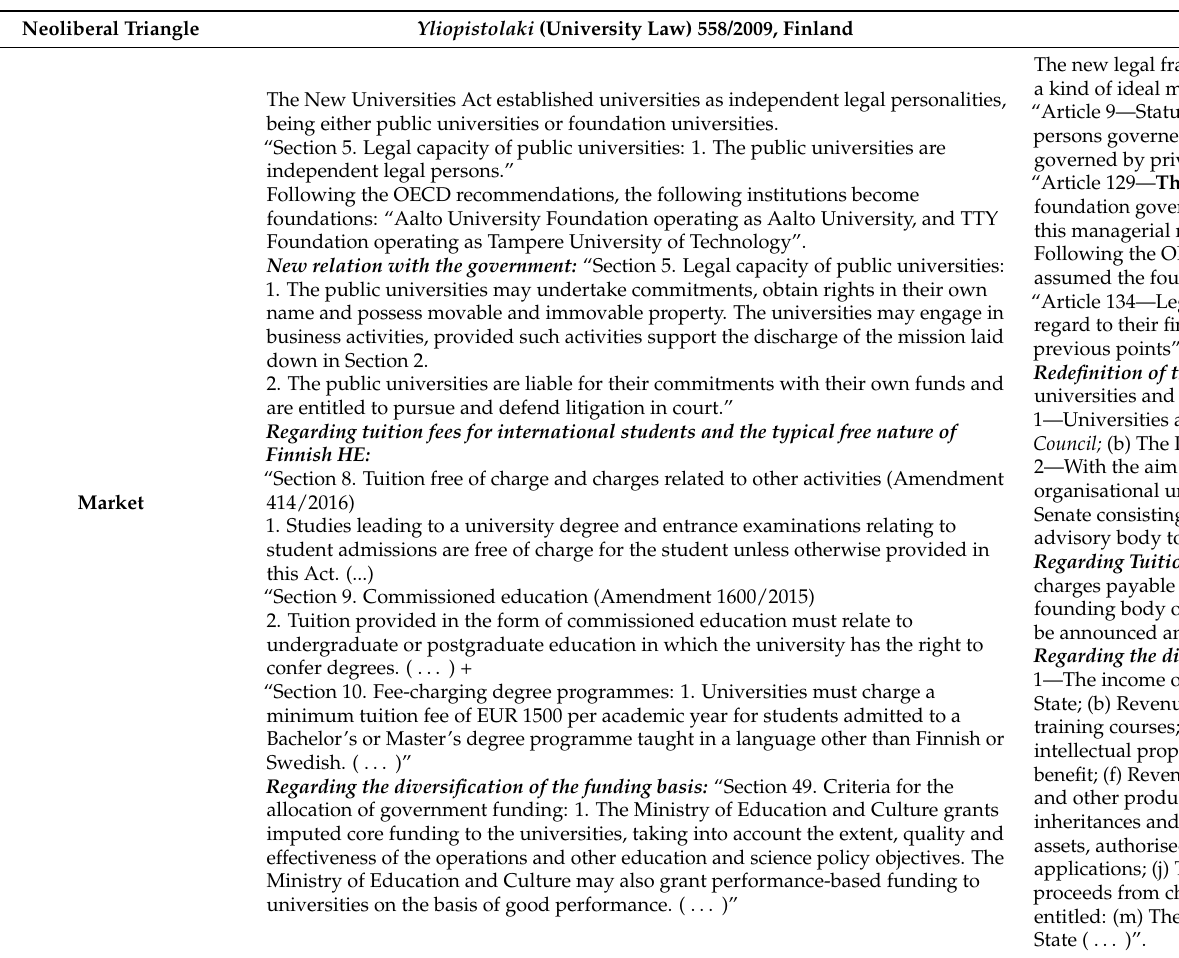
Table A2. How Portugal and Finland translated the OECD proposes based in three main components of neoliberalism—market, management and performativity (Ball